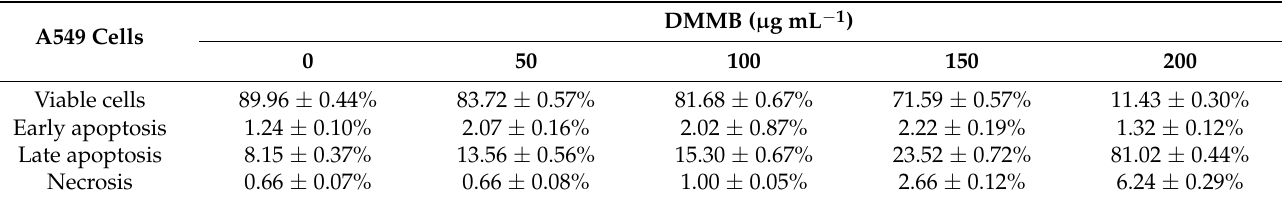
Table 4. Cytotoxicity of DMMB against A549